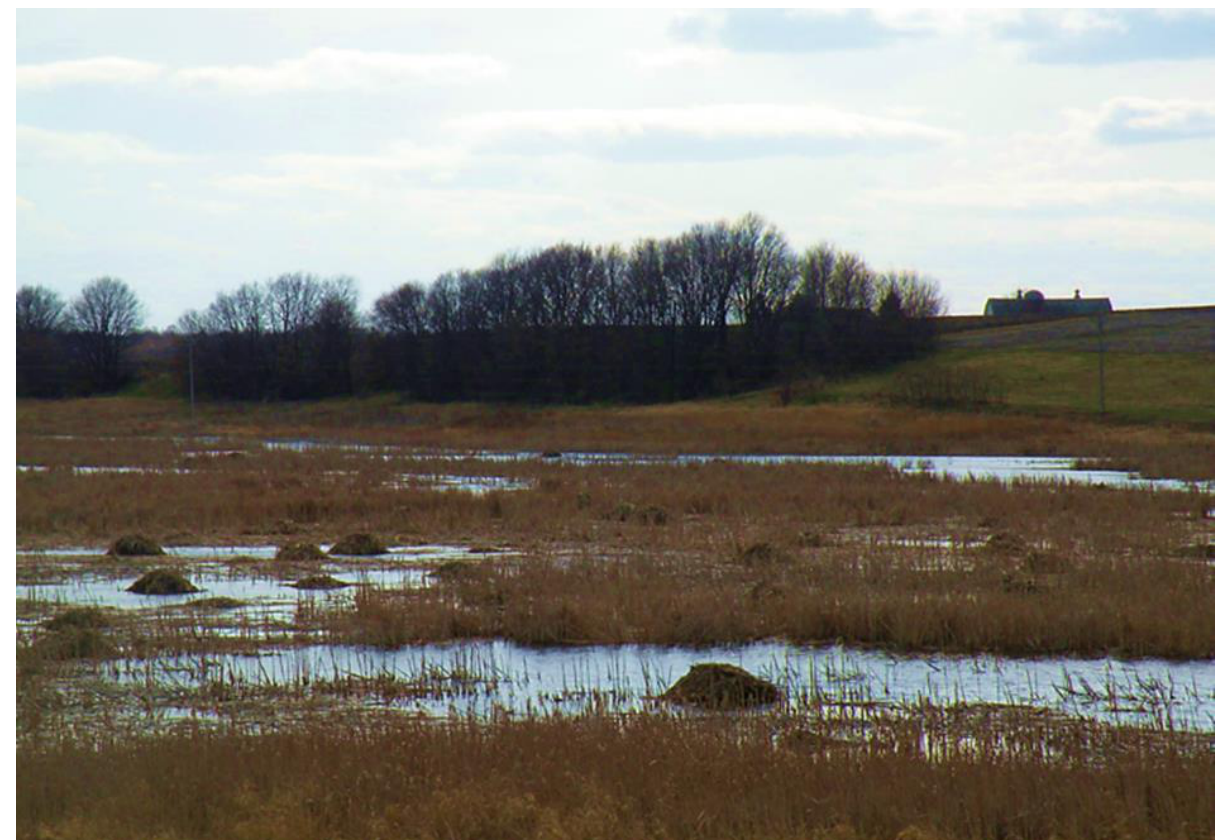
Figure 1. Hemi-marsh located near Waconia, Minnesota and open water accentuated by muskrat activity. 10 April